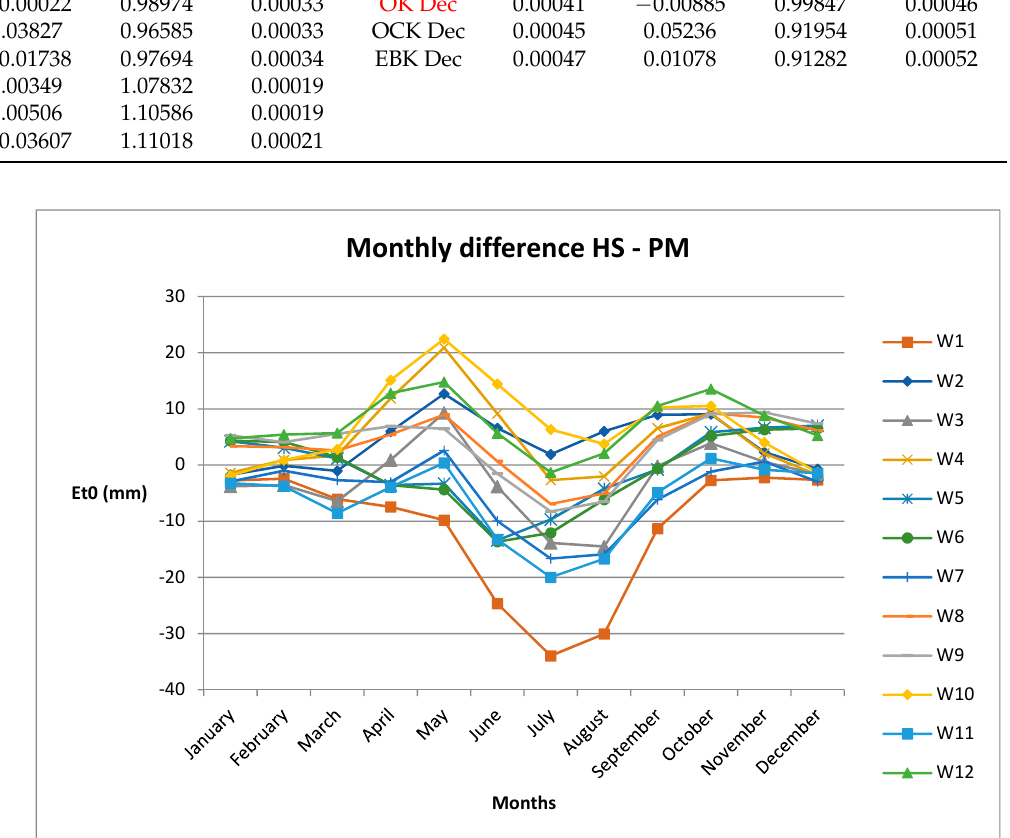
Figure 4. Monthly ET0 difference between HS and PM for all weather stations.